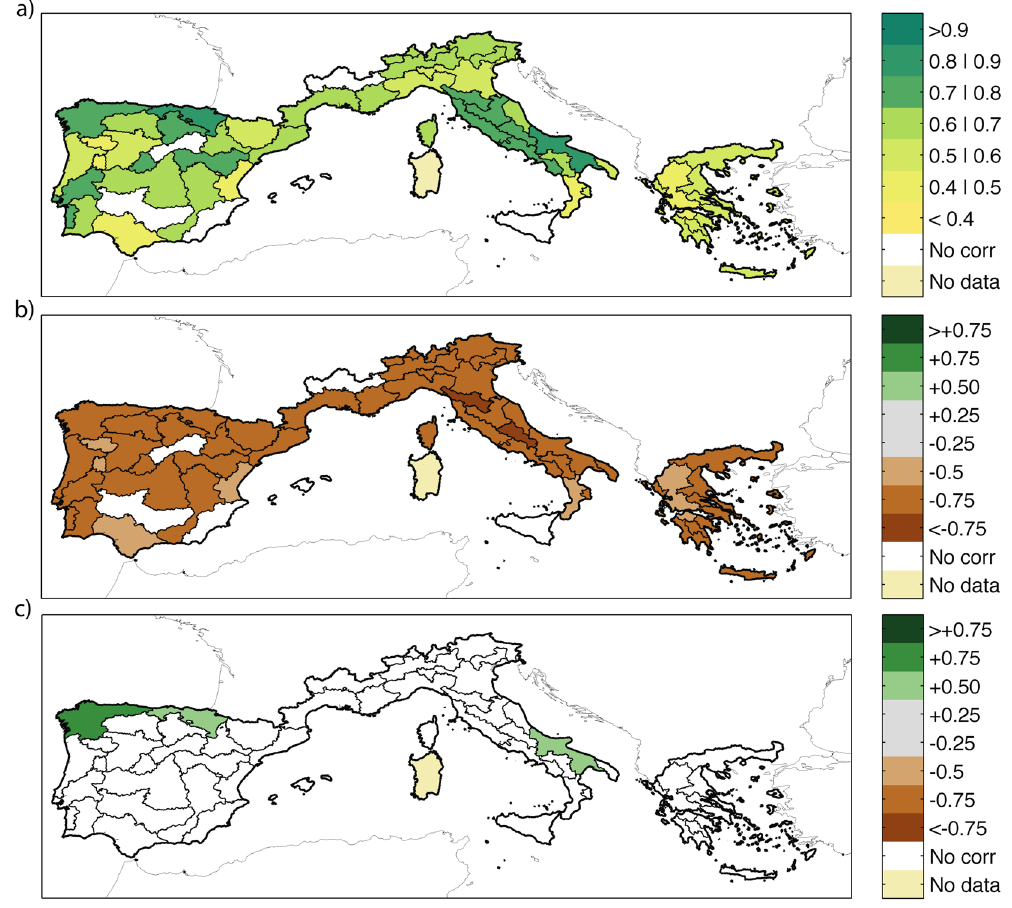
Figure 4. MLR results: ( a ) correlation between modelled and observed log( BA ) (detrended) for each eco- region; ( b ) coefficient weights for the coincident drought conditions (SPEI); ( c ) coefficient weights for the antecedent drought conditions (SPEI). This figure is created with Matlab version R2012a (http://www.